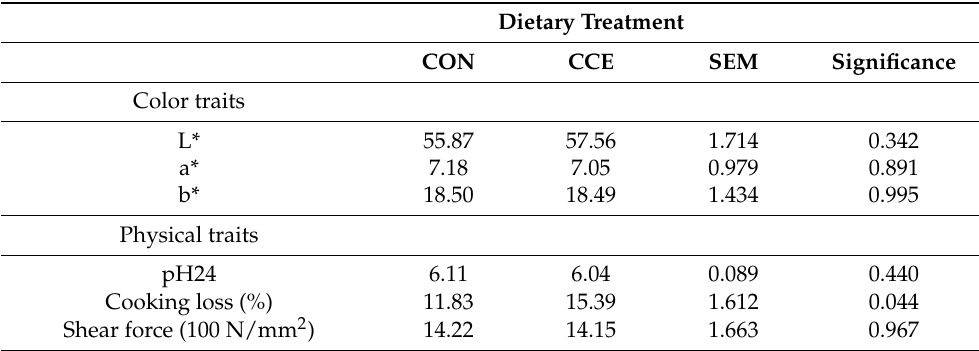
Table 7. Carcass quality based on selected parameters among the two dietary treatments (Control; CON and carotenoid extract from Citrus reticulata included in soluble starch;